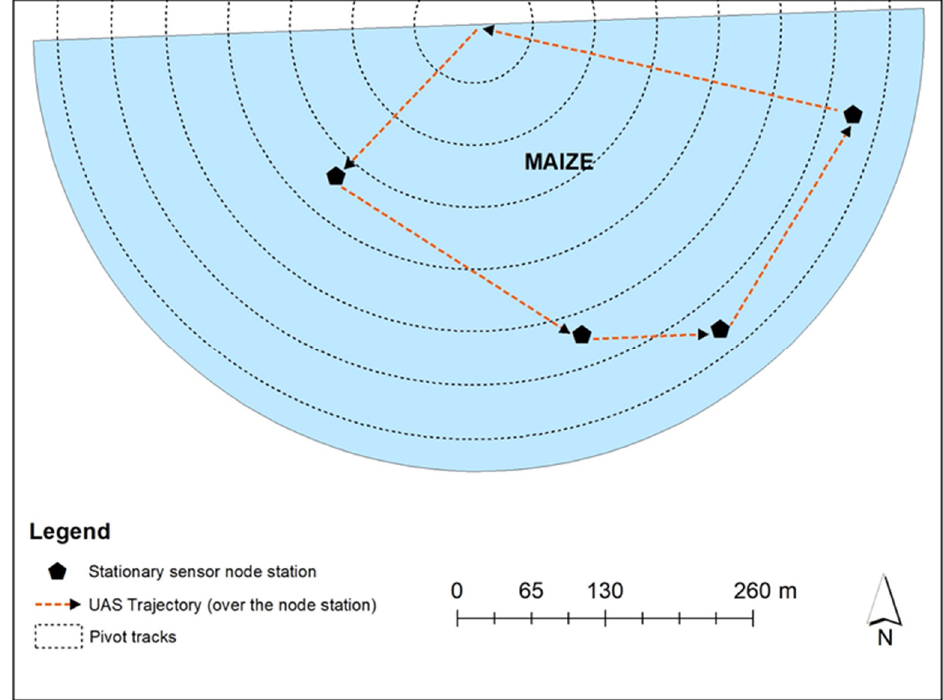
Figure 3. Location of stationary sensor node stations and the trajectory of UAS for four replications during the 2020 growing season. There were three replications of UAS flights that were conducted over the node stations at a height of: (i) 31 m; (ii) 61 m; and (iii) 122 m. During 2021, communication was attempted with the five replicate node stations at a hovering height of 31 m above the stations and at lateral distances between the UAS and station of 0 m, 38 m, and 76 m during nine flight days (Figure 4). Signal interference due to crop canopy cover was expected to be maximum from the mid to late growing season of